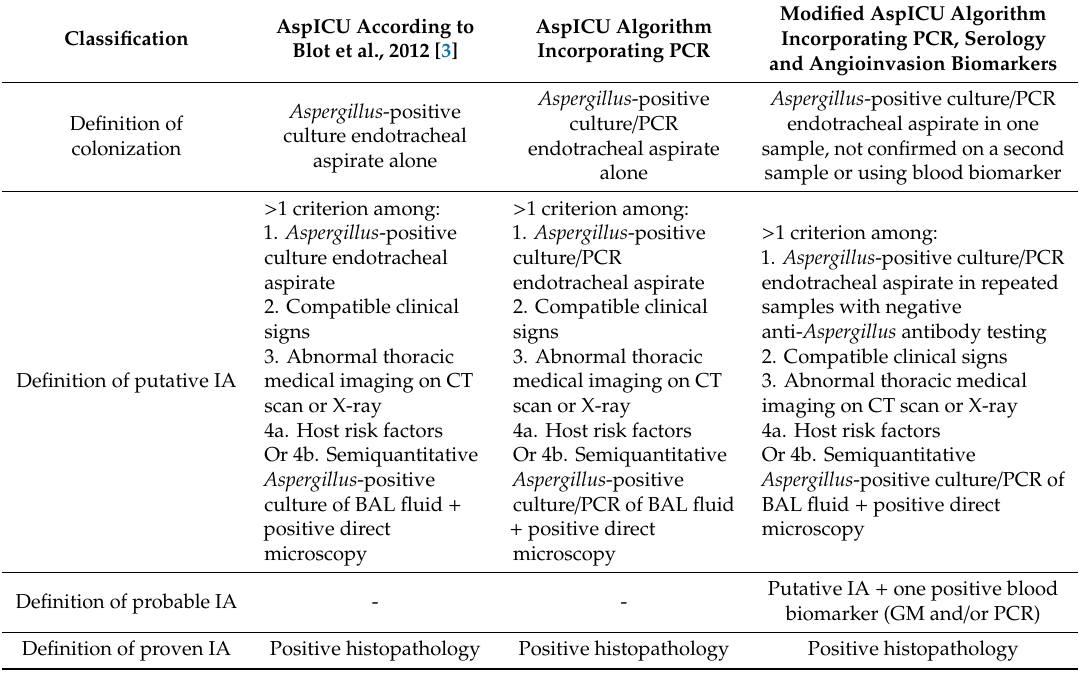
Table 1. Diagnostic criteria of the AspICU clinical algorithm according to Blot et al., 2012, and proposal of a modified AspICU algorithm.